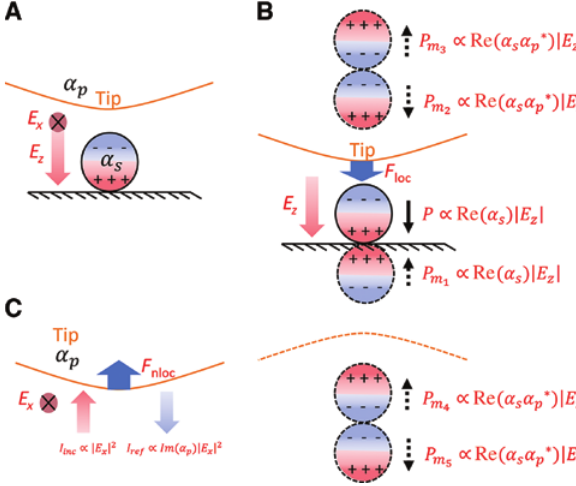
Figure 1: Optical forces detected by an atomic force microscope (AFM) tip [49, 50]. (A) Particle, tip, and electrical field; (B) photo-induced dipole (circled by black curve), and its mirror images (circled by black dashed curve). The dipoles create an attractive force to the tip, which decreases in z −4 with the distance between the tip and the particle. (C) Radiation pressure results in a nonlocalized force, which is independent of the tip